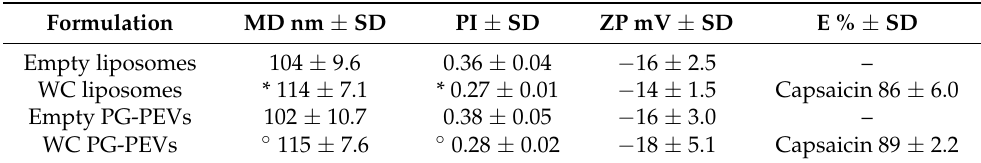
Table 2. Characteristics of empty and white Capsicum (WC) loaded vesicles: mean diameter (MD), polydispersity index (PI), zeta potential (ZP), and entrapment efficiency (E). Each value represents the mean ± S.D. ( n > 10). *, ◦ values statistically different ( p < 0.05) from empty liposomes and empty PG-PEVs,